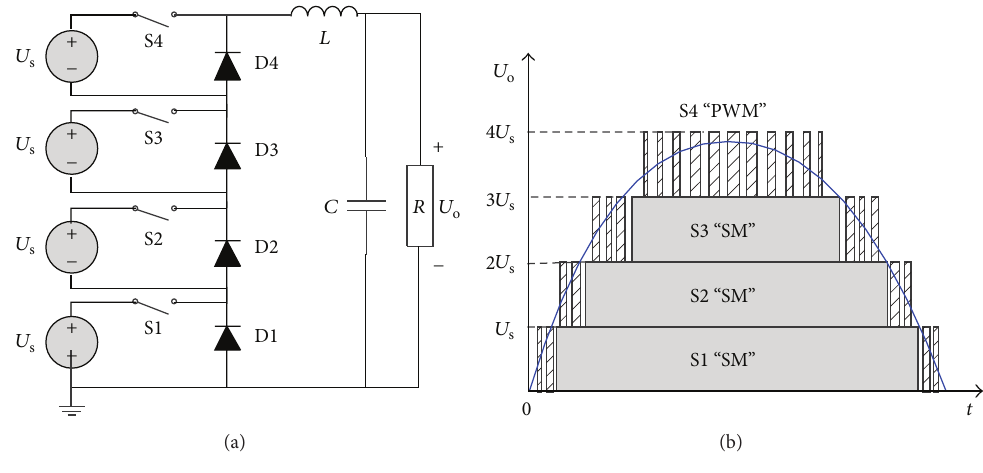
Figure 2: PSM-based HVPS. (a) Schematic and (b)